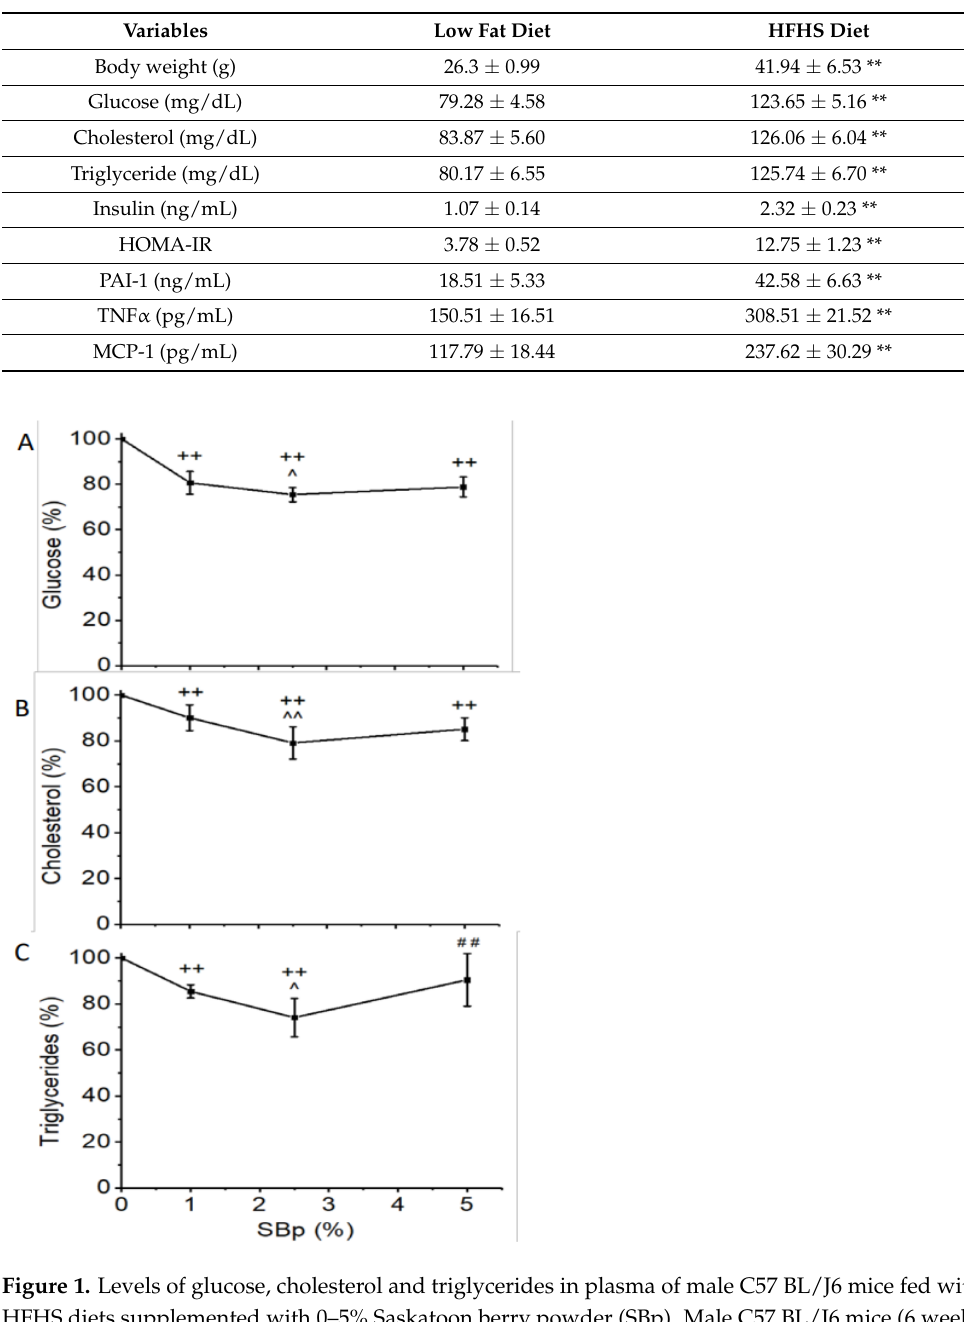
Table 1. Difference in body weight, metabolic and inflammatory variables between mice received low fat diet and high fat-high sucrose (HFHS) diet. HOMA-IR: homeostatic model assessment- insulin resistance; PAI-1: plasminogen activator inhibitor-1; TNF α : tumor necrosis factor- α ; MCP-1: monocyte chemotactic protein-1. Values were expressed in mean ± SD ( n = 8/group). **: p < 0.01 vs. low fat diet group.